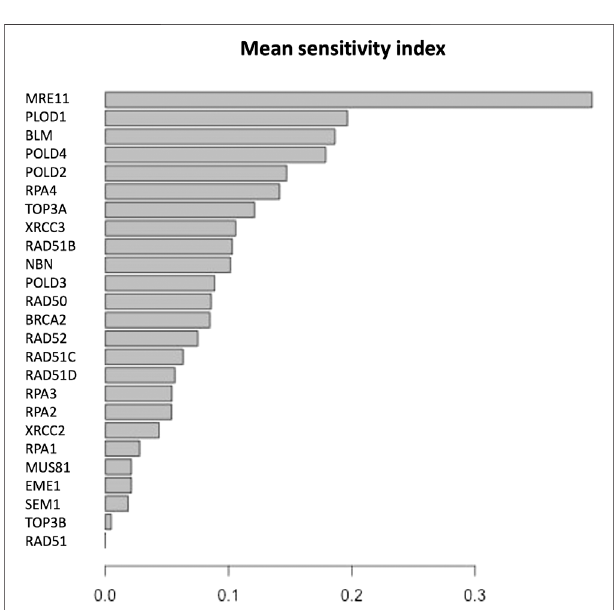
FIGURE6| Coef fi cientofvariationofthesensitivityindexdistributionsfor the proteins in HR network Orlic-Milacic, (2015). These results refer to simulation in the time interval [0, 10] a.u., and initial values of the proteins randomly sampled in the range [1, 100] a. u. and kinetics rates values sampled in the interval [0, 0.01].